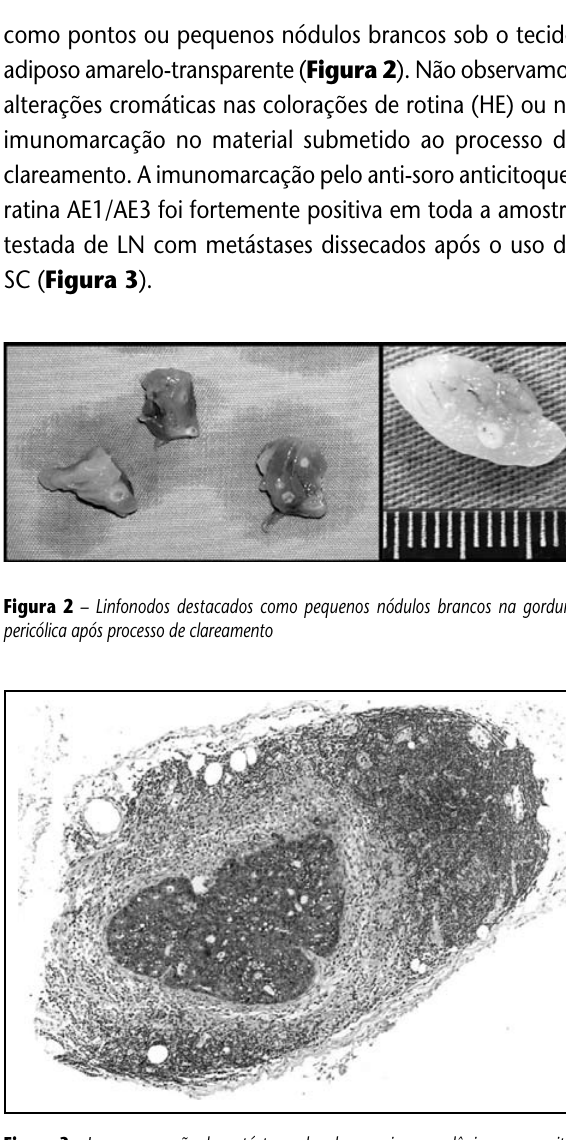
Figura 3 – Imunomarcação de metástases de adenocarcinoma colônico por pancito- queratina (Anti-soro AE1/AE3; aumento original 100x)